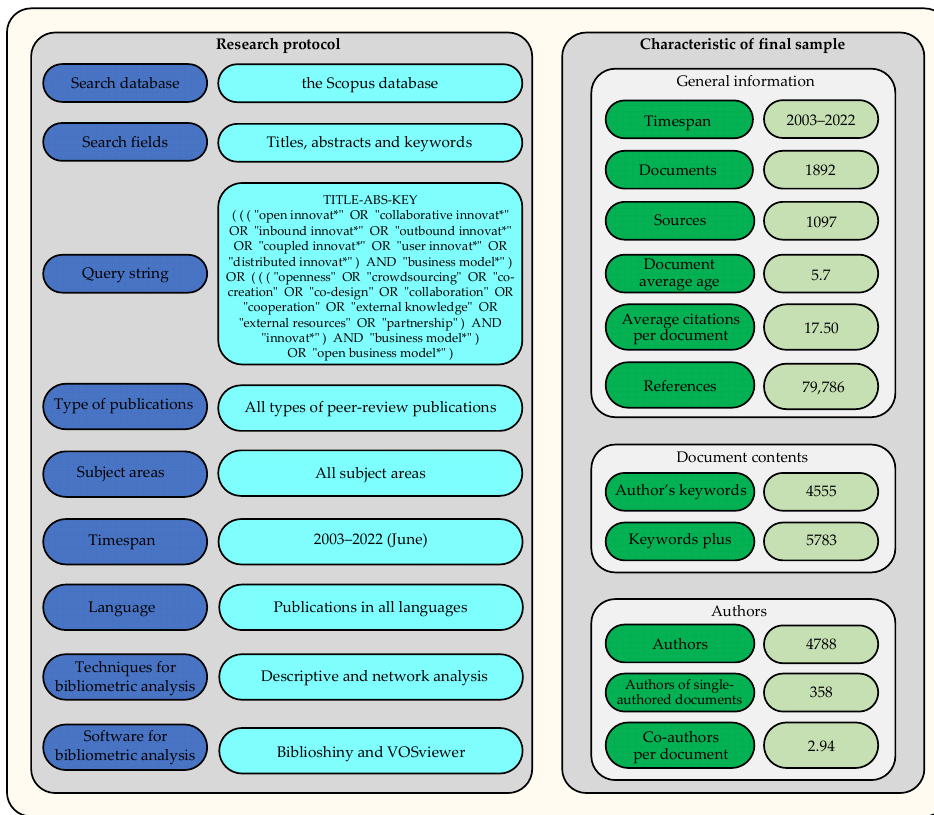
Figure 1. Research protocol and characteristic of research sample.